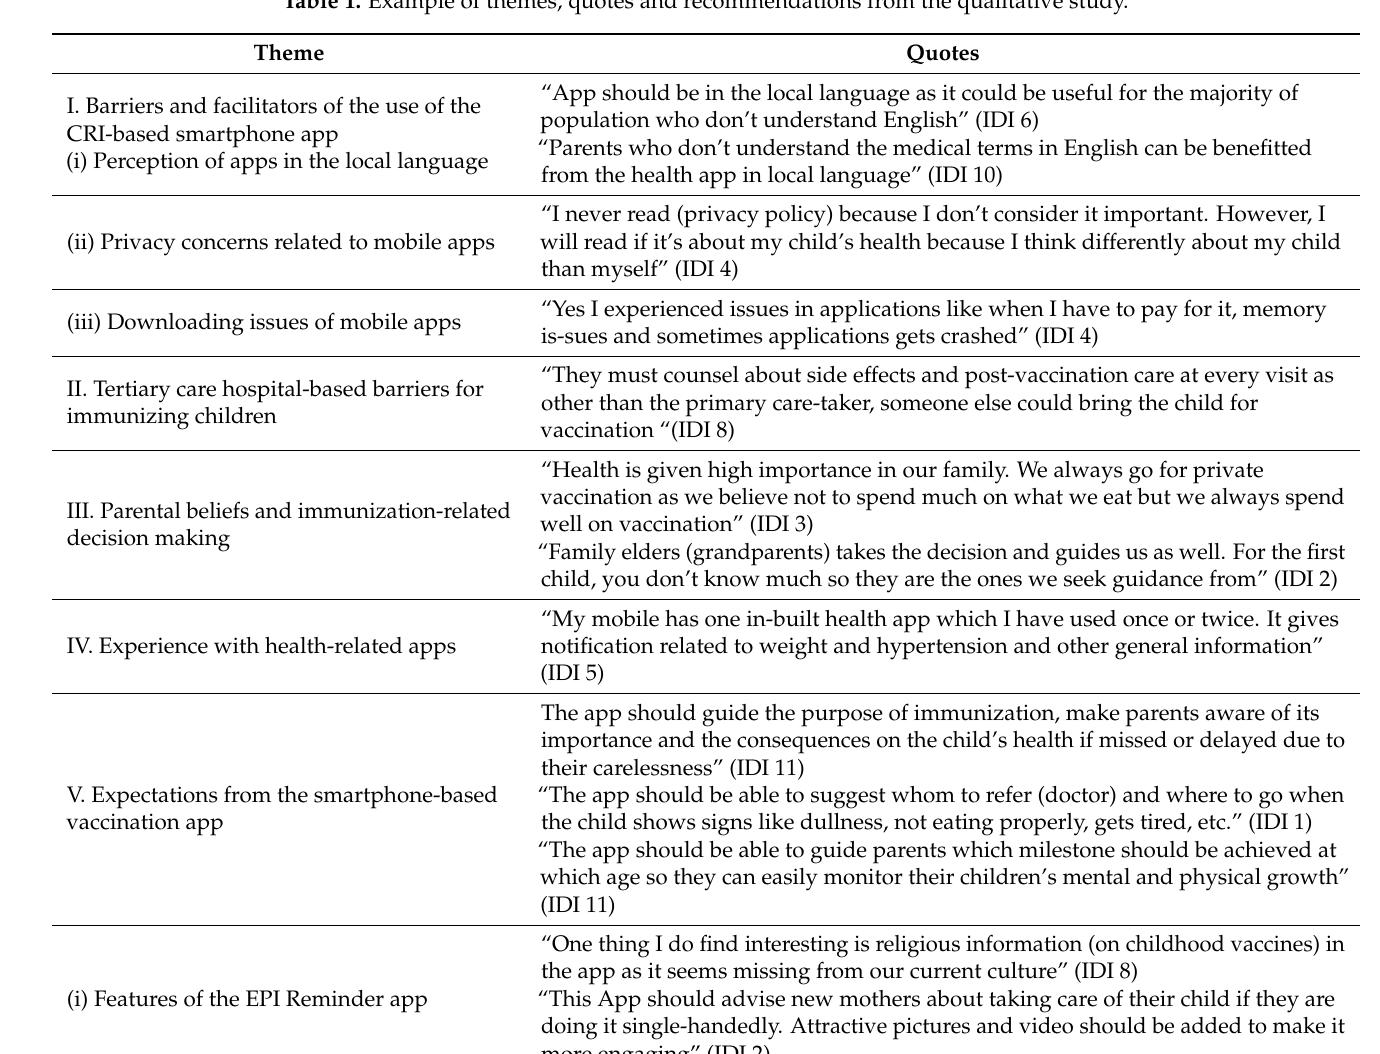
Table 1. Example of themes, quotes and recommendations from the qualitative